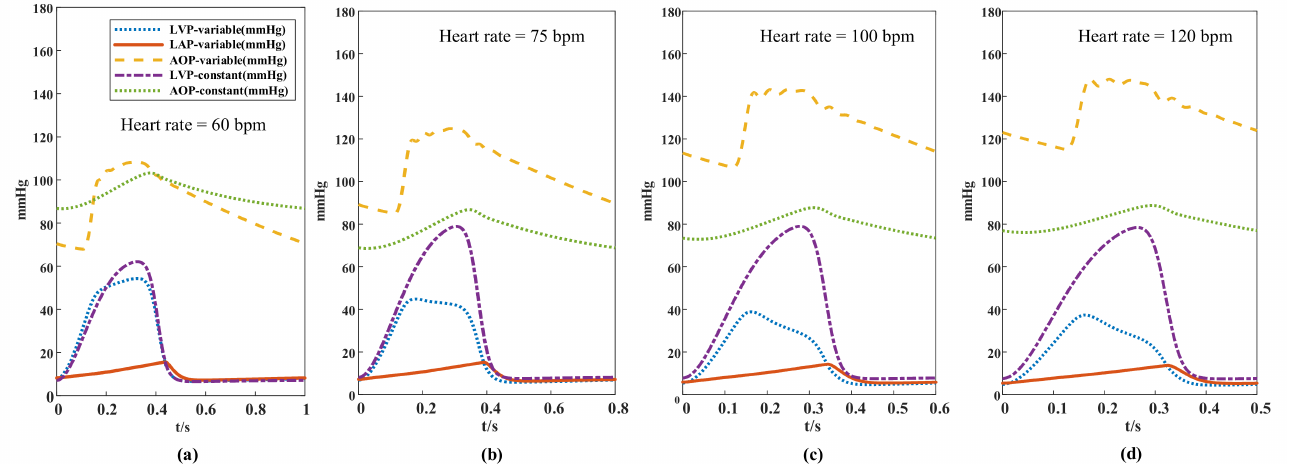
Figure 9. The pressure waveforms of different heart rates in the two auxiliary strategies; LVP-variable: left ventricular pressure with variable-speed assist; LAP-variable; left atrial pressure with variable- speed assist; AOP-variable: aortic pressure with variable-speed assist; LVP-constant with variable- speed assist: Left ventricular pressure with constant-speed assistance; LAP-constant: left atrial pressure with constant-speed assistance. ( a ) heart rate = 60 bpm, ( b ) heart rate = 75 bpm, ( c ) heart rate = 100 bpm, ( d ) heart rate = 120